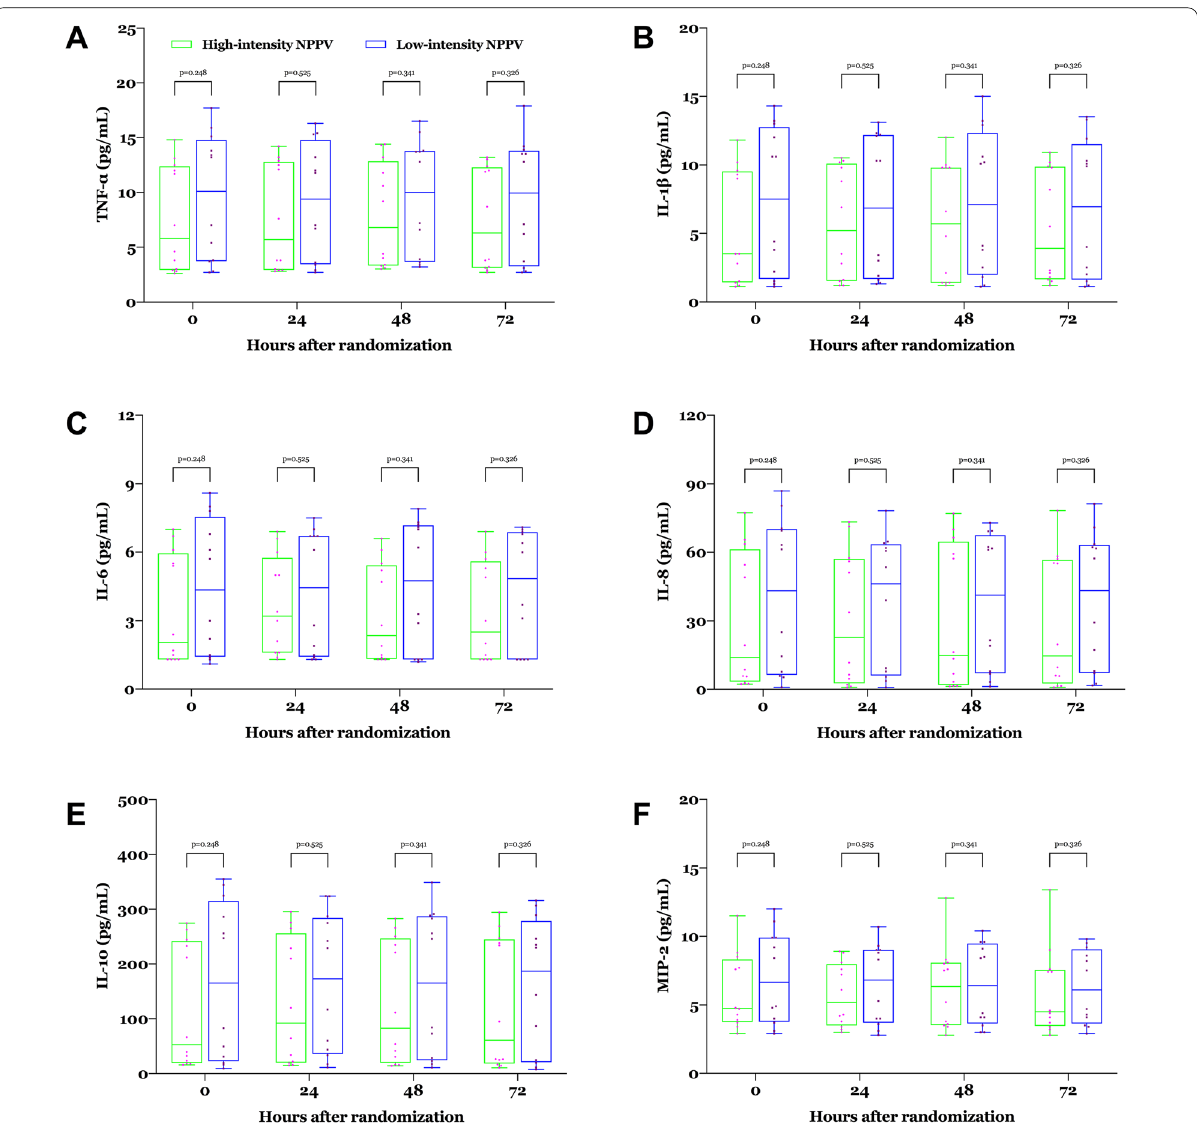
Fig. 6 Plasma levels of a TNF-α, b IL-1β, c IL-6, d IL-8, e IL-10, and f MIP-2 from baseline through 72 h after randomisation. Values are individuals, medians, and interquartile ranges with whiskers indicating minimum and maximum. NPPV noninvasive positive pressure ventilation, TNF tumour necrosis factor, IL interleukin, MIP macrophage inflammatory